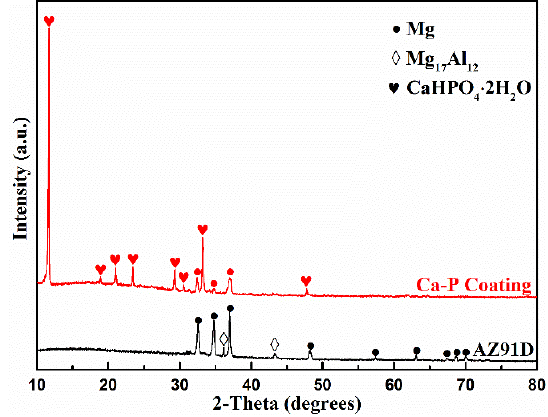
Figure 9. XRD patterns of the bare AZ91D sample and the AZ91D samples with Ca-P conversion coating.